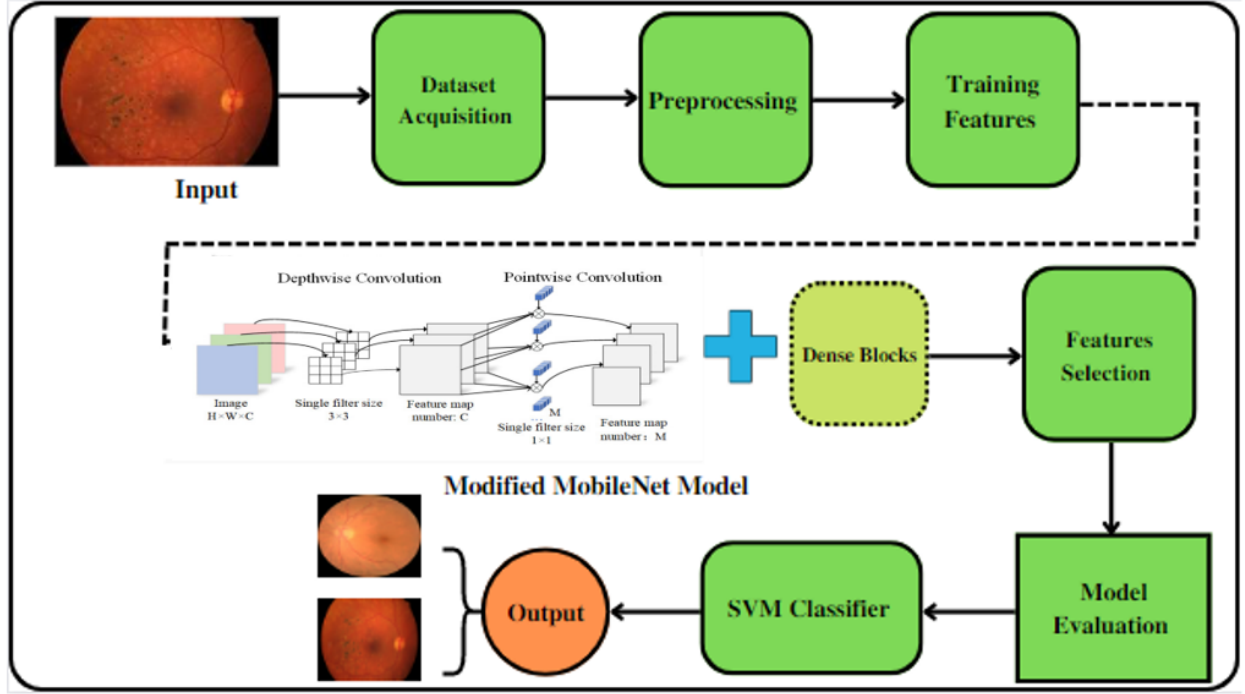
Figure 3. A systematic flow diagram of the proposed Mobile-HR system for the diagnosis of hypertensive retinopathy eye-related disorders. Table 2. Image data of the retina for the Mobile-HR